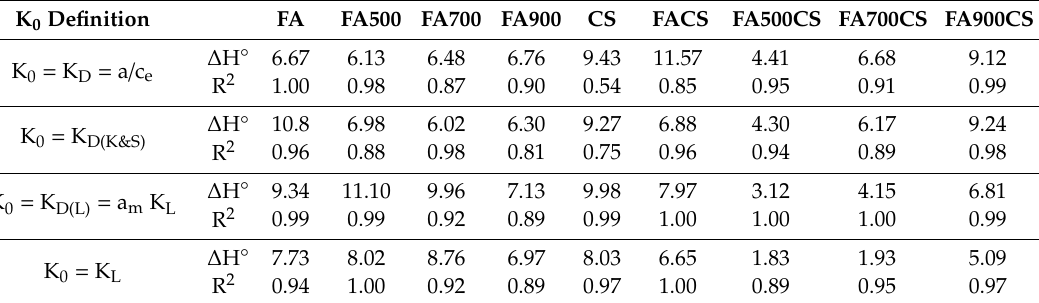
Table 8. Free enthalpies ∆ H ◦ , kJ mol − 1 , calculated using di ff erent modes of K 0 estimation and correlation coe ffi cients for linear fits of experimental points to Equation